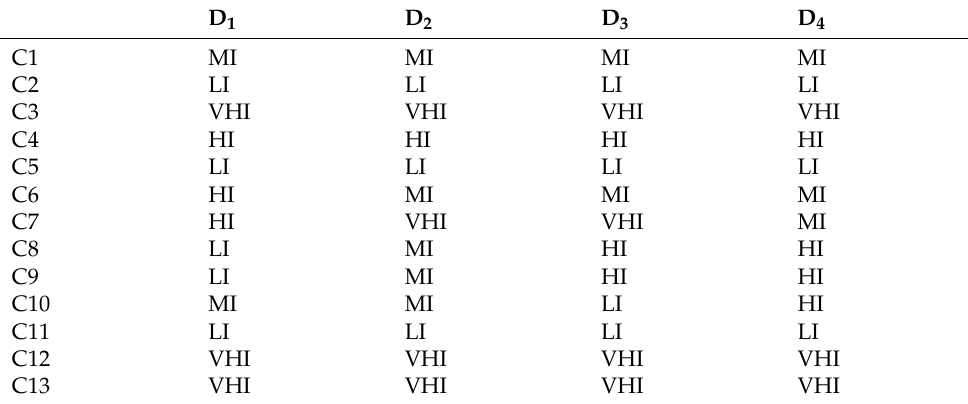
Table 4. Decision makers’ linguistic assessment of the